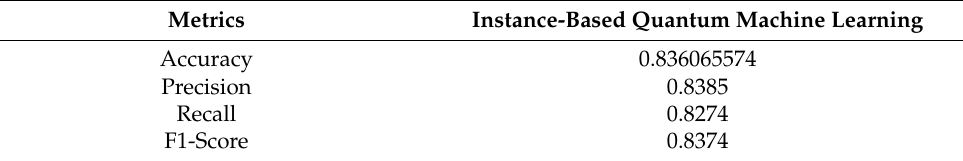
Table 4. Performance evaluation of proposed quantum-based machine learning.